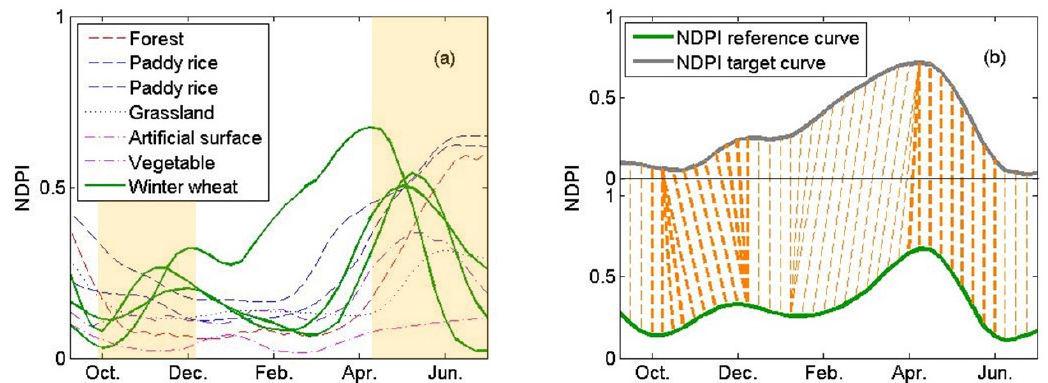
Figure 5. ( a ) NDPI curves for different land cover types. Winter wheat shares common characteristics in the two periods with light yellow backgrounds: the NDPI increase before winter and decrease after heading. ( b ) Phenological weighting strategy of PT-DTW (the thicker dashed line represents greater weight).